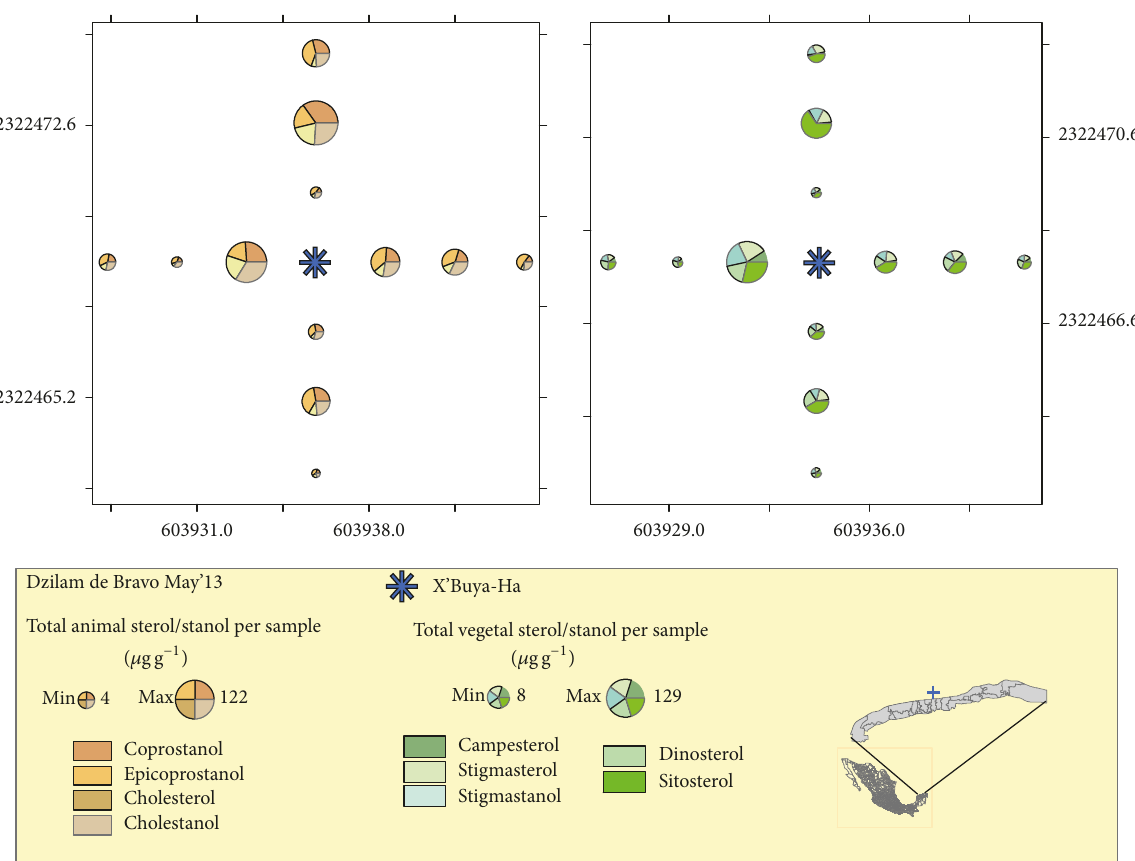
Figure 6: Spatial distribution of sterols and stanols surrounding the X’Buya-Ha spring in dry season (May 13).